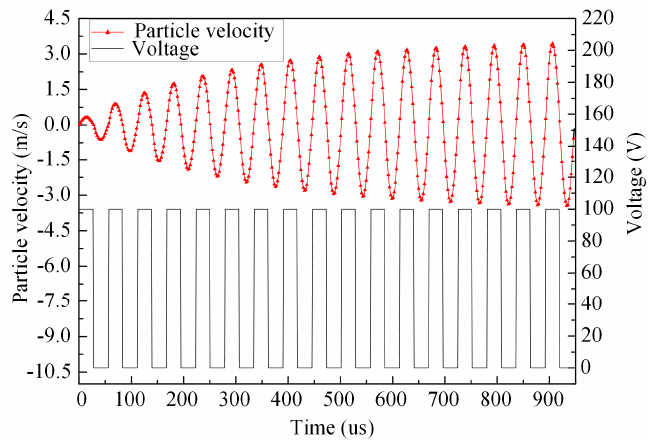
Figure 2. The particle velocity and its corresponding pulse voltage.